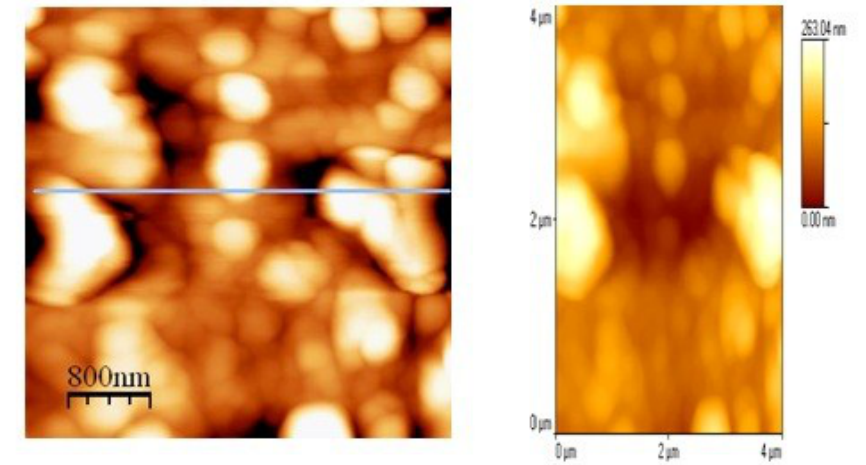
Figure 3. AFM image of 2D form of Polyreactive blue MXR